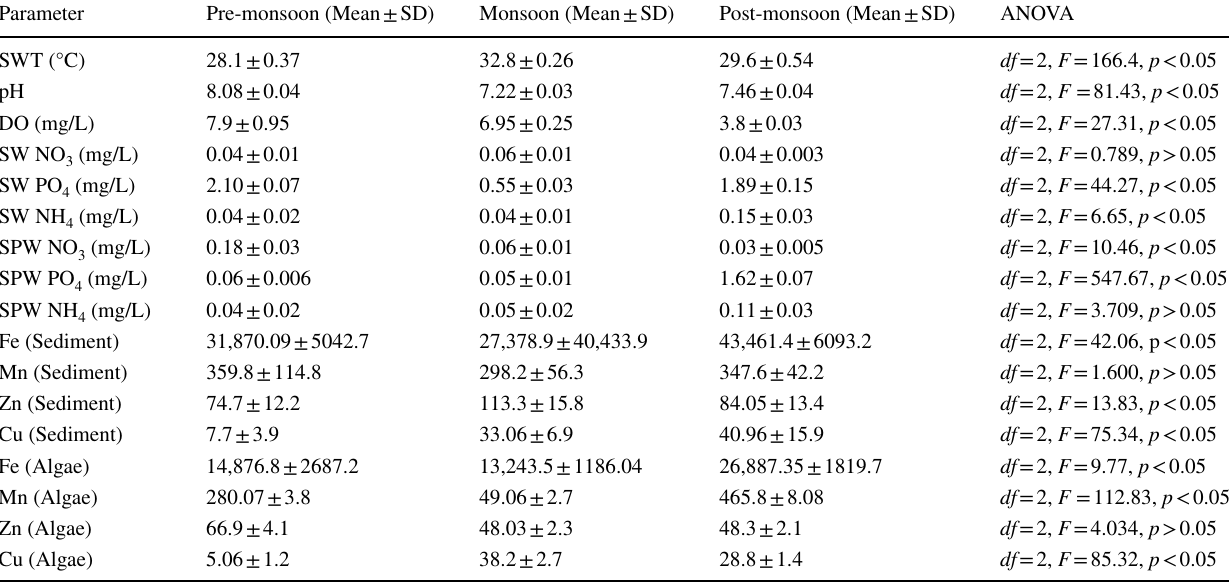
Table 4 Analysis of variance (ANOVA) in physicochemical characteristics of water and sediments among the seasons